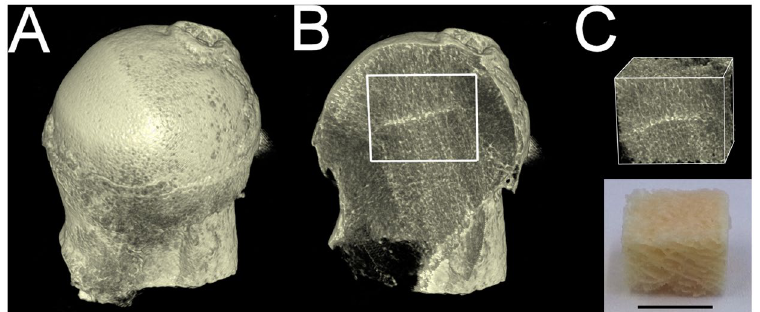
Figure 1. 3D-reconstruction of a femoral bone sample showing the biopsy location. ( A ) Anterior view, ( B ) coronal section from the mid-plane with the biopsy site marked, ( C ) reconstruction of the bone biopsy and a photograph of the biopsy with bone marrow removed. Scale bar presents 1.0